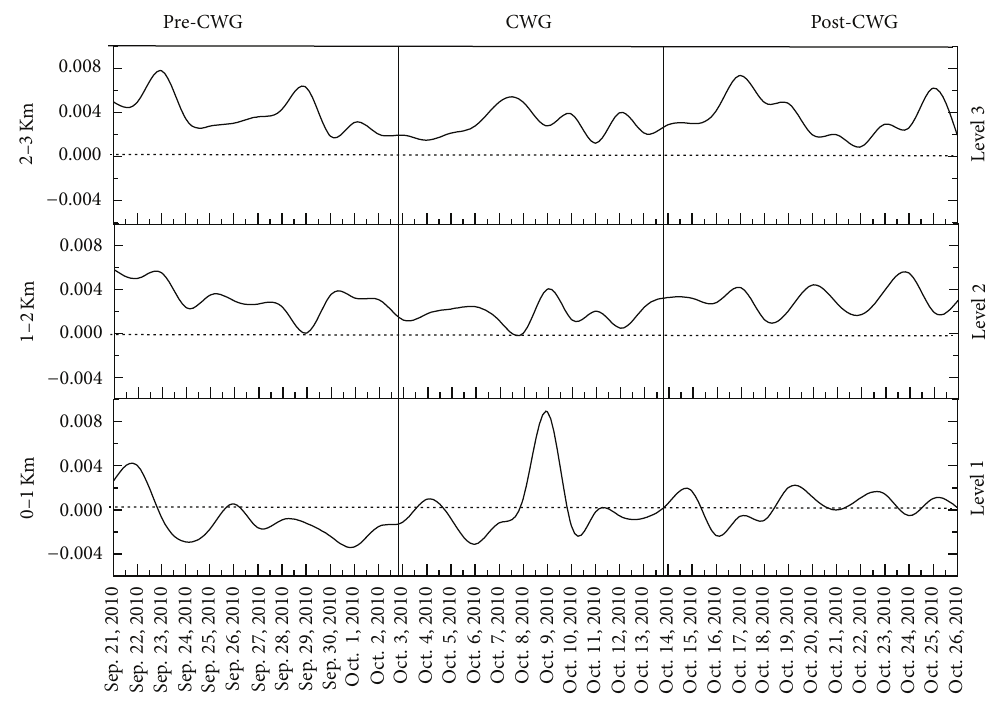
Figure 6: Change in potential temperature with respect to the altitude for the 3 periods (pre, during, and